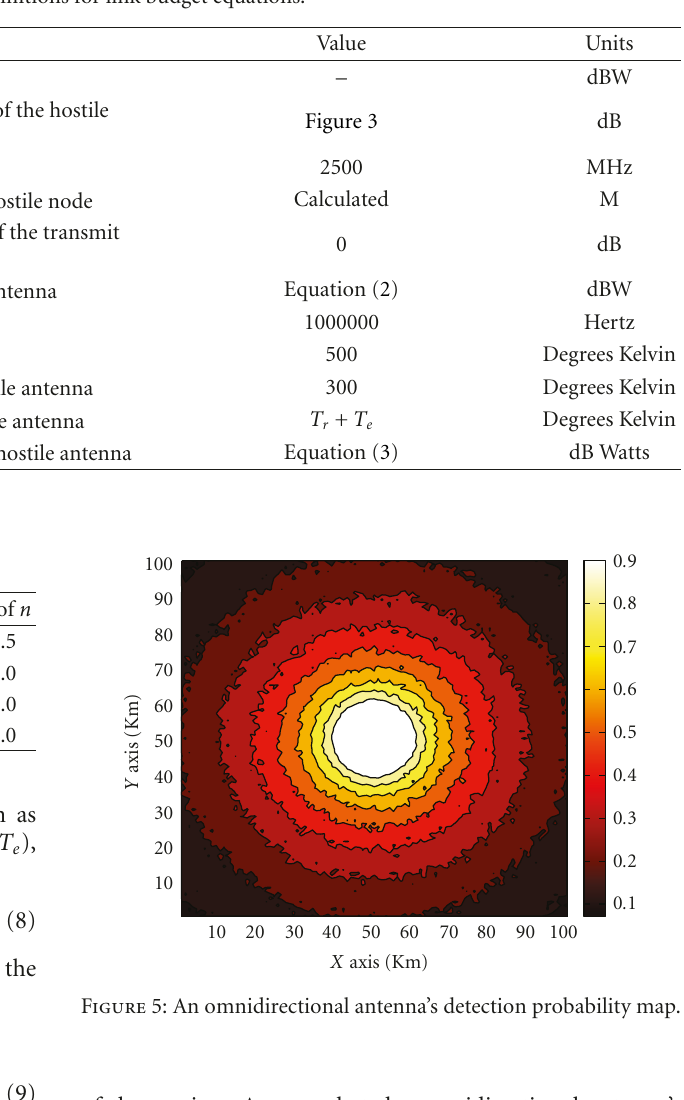
of the receiver. Assume that the omnidirectional antenna’s